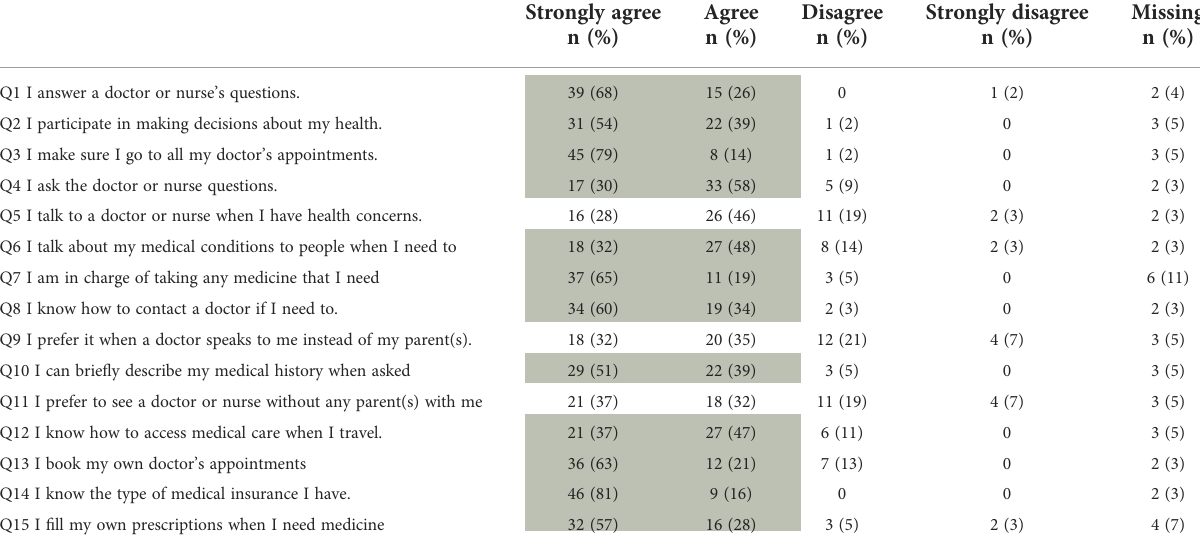
TABLE 2 Results from the Self-Management Skills Scale, shaded areas indicating at least 75% agreement with the respective statement (n=57).